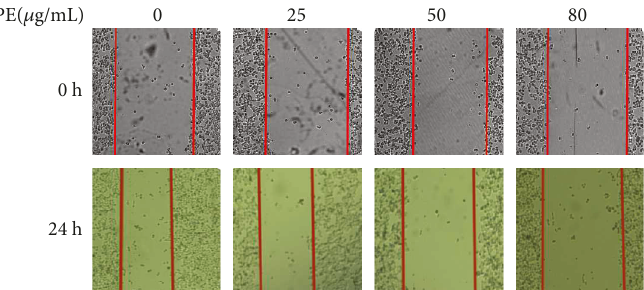
Figure 3: The e ff ect of GSPE on the migration of ECA109. The e ff ect of GSPE (0 – 80 μ g/mL) on ECA109 migration was analyzed by using a cell scratch test. Each treatment was assayed in triplicate. After incubation at 37 ° C for 24 h, the cells were observed by an inverted microscope (magni fi cation, ×